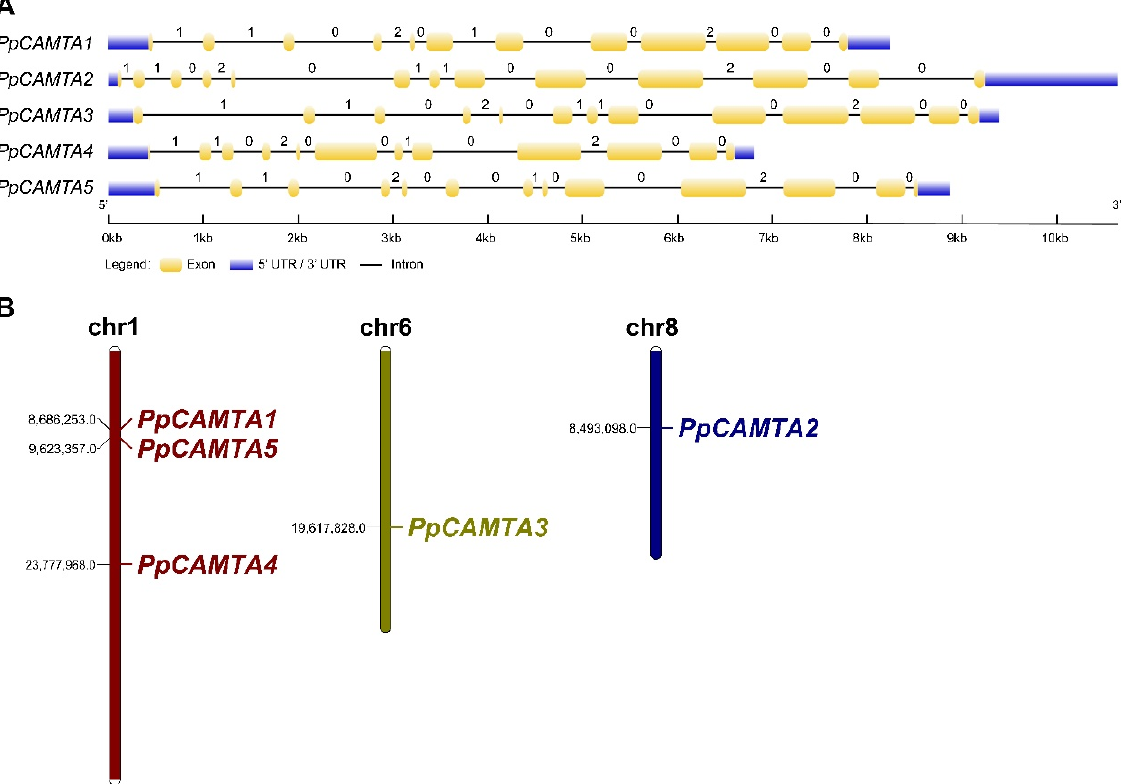
Figure 2. Distributions of exon-intron and chromosomal locations of peach CAMTA genes. ( A ) Distributions of exon-intron of peach CAMTA genes. Blue boxes represent UTR regions, black lines represent introns and yellow boxes represent exons. The numbers on introns indicate their phase type: Phase 0 intron does not disrupt a codon, phase 1 intron disrupts a codon between the first and second bases, and phase 2 intron disrupts a codon between the second and third bases. ( B ) Chromosome distributions of peach CAMTA genes. The chromosome number was shown at the top of each chromosome.